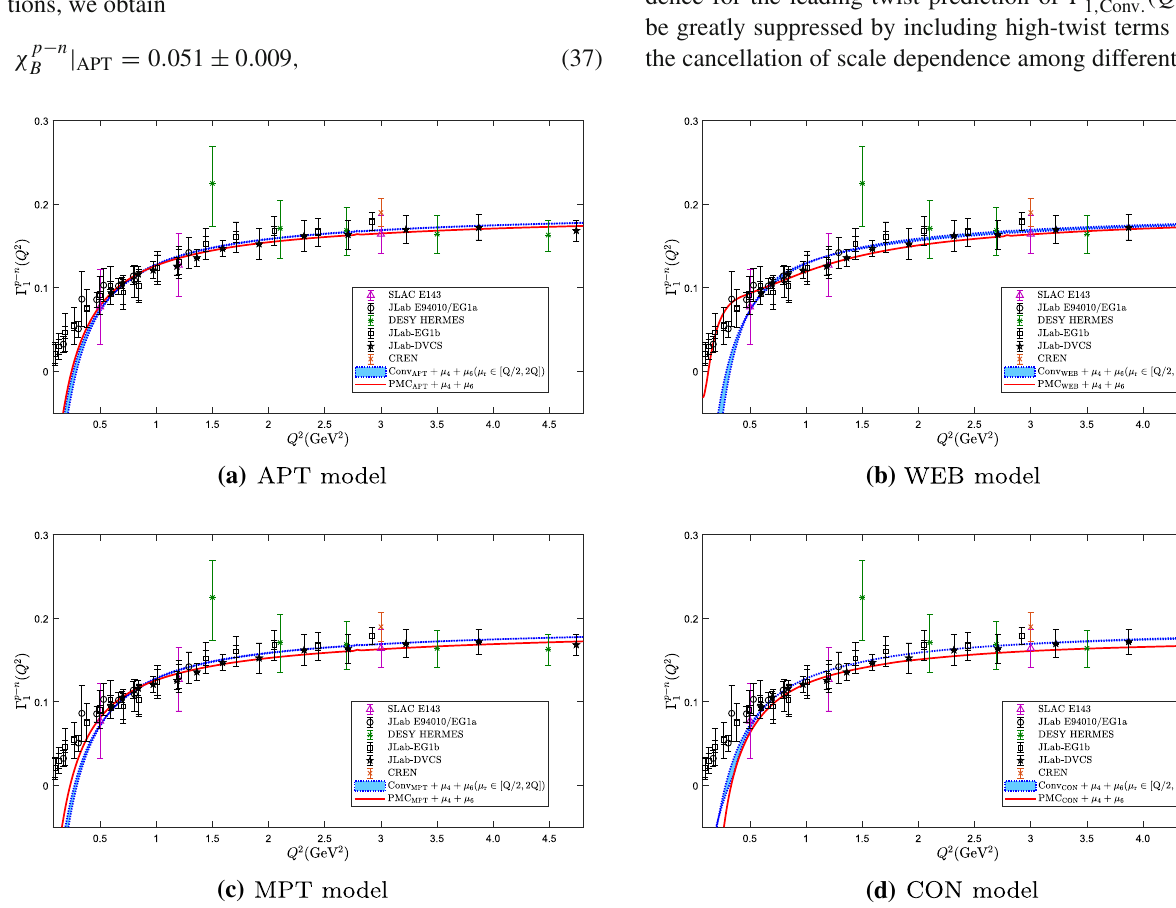
predictions for the hard-part of the leading-twist contribu-